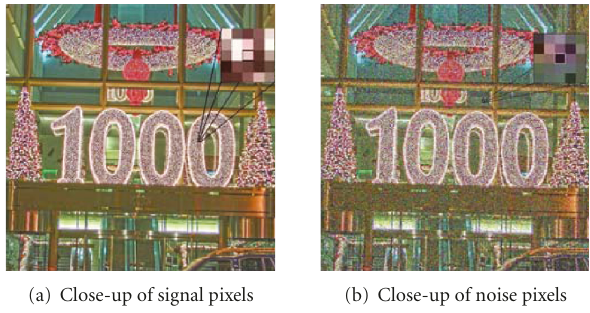
Figure 2: Close-ups of signal pixels in the “Neon Light” image and noise pixels in image corrupted by 15% impulse